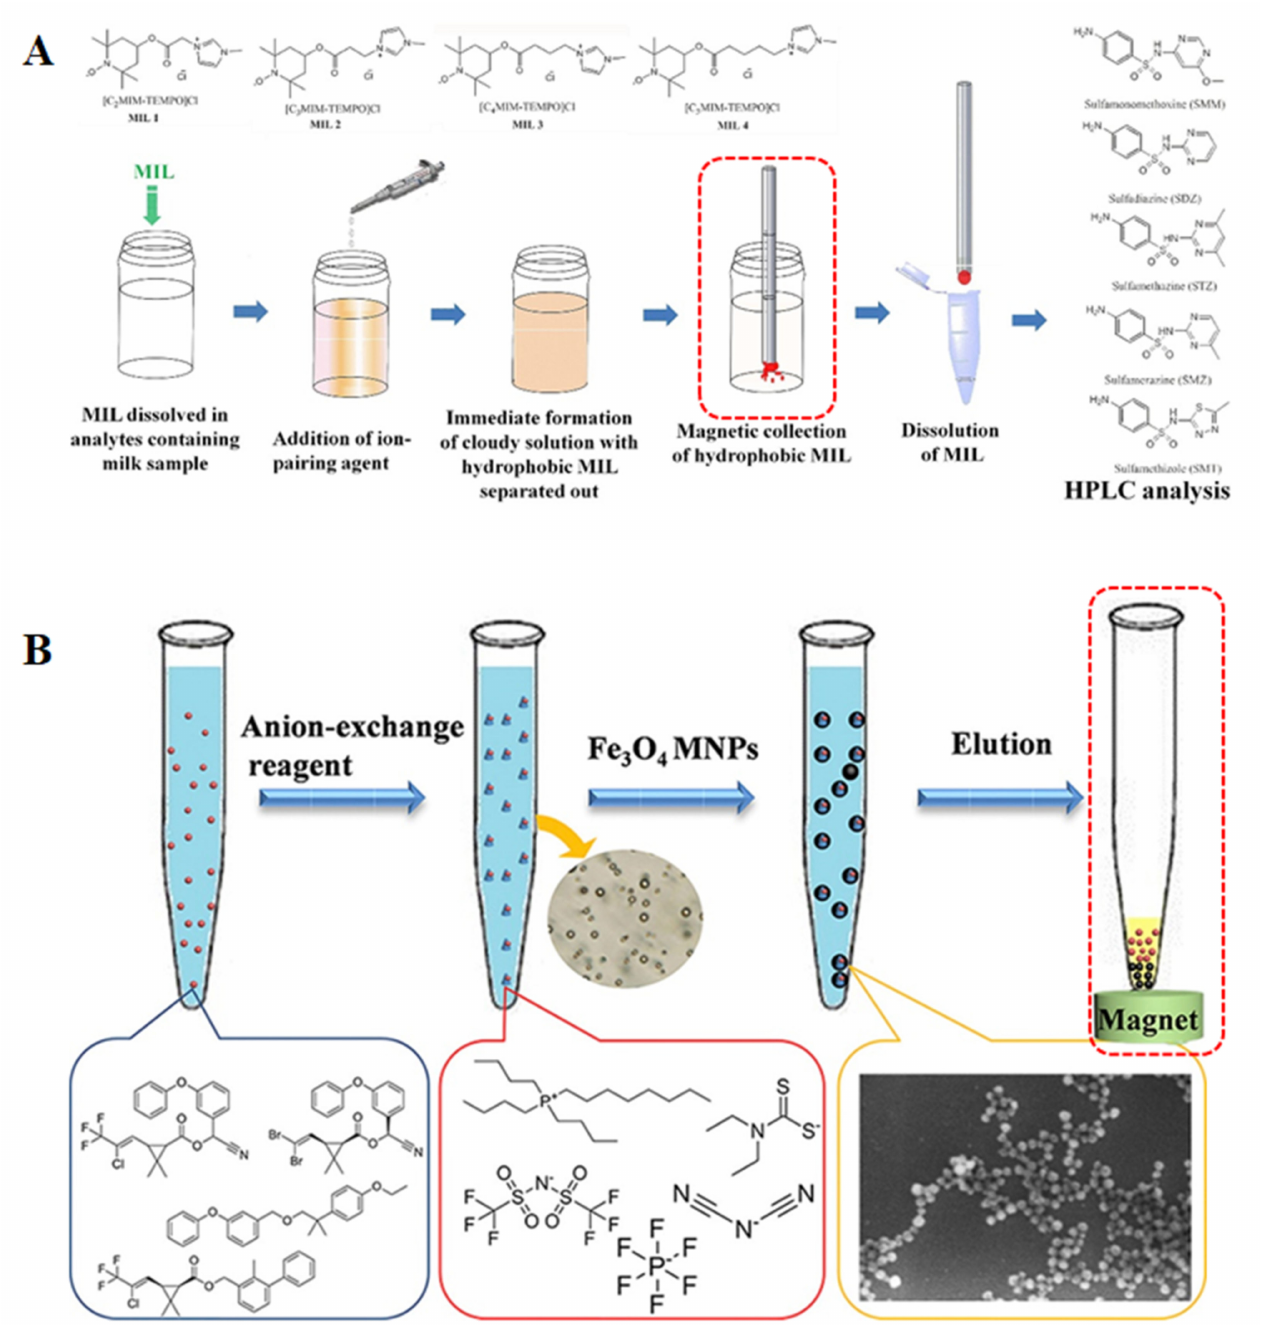
Figure 3. Magnetic separation in the DLLME of ( A ) MILs and ( B ) Fe 3 O 4 magnetic nanoparti- cles